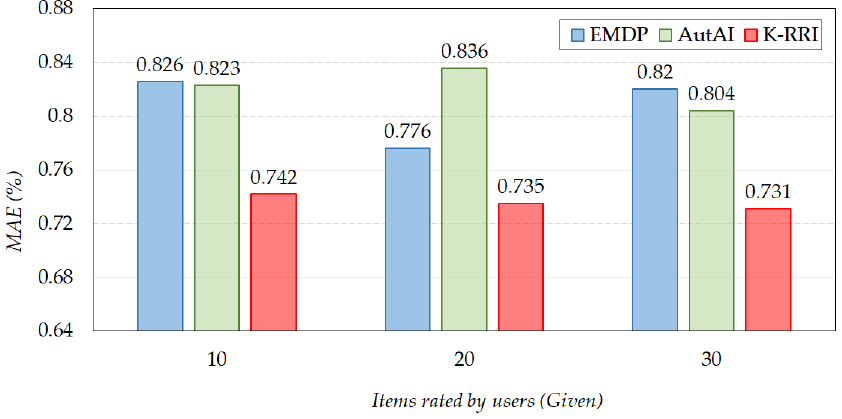
Figure 6. The prediction accuracy of missing data imputation algorithms.